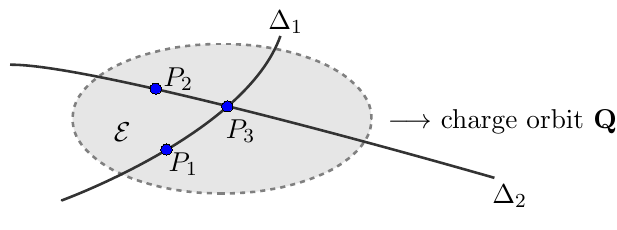
Figure 11 . The canonical case of two singular divisors intersecting on a local patch E in moduli space. The considered in(cid:12)nite distance points P can be located either on (cid:1) (cid:14) exempli(cid:12)ed by P 1 , P 2 , and P 3